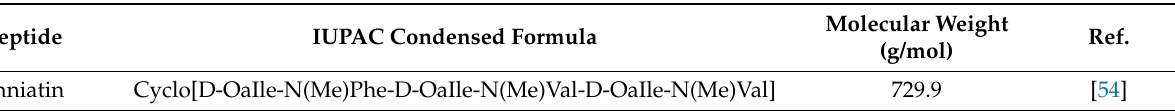
Figure 3. Staging model of depsipeptides inducing autophagy in tumor cells. Table 2. Formula and molecular weight of beauvenniatin, a depsipeptide triggering autophagy in tumor cells.